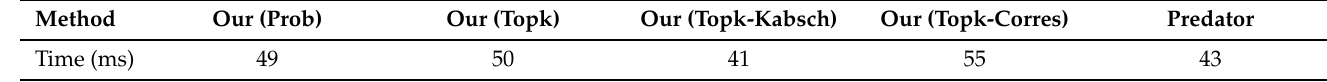
Table 6. The runtime of our model with different estimators and